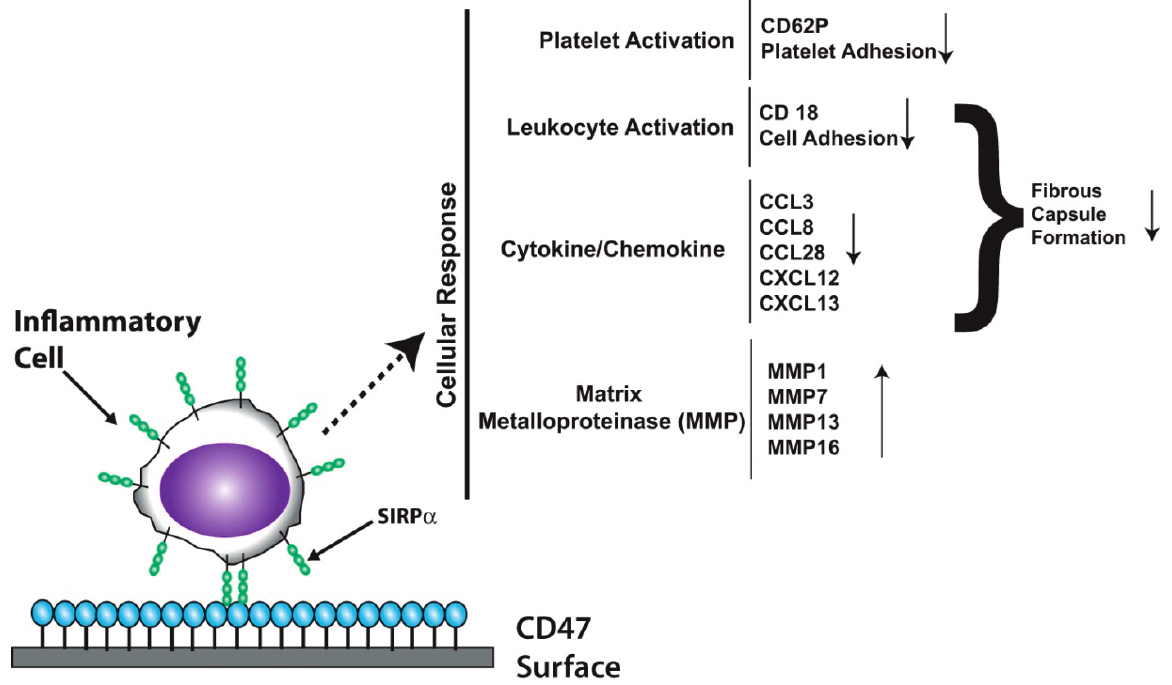
Figure 4. Genes regulated by the CD47-SIRP α interaction. Blood exposure to CD47-functionalized surfaces triggers signaling cascades that result in the down regulation of genes involved in platelet activation, leukocyte activation, and select cytokines/chemokines, and the up-regulation of MMP